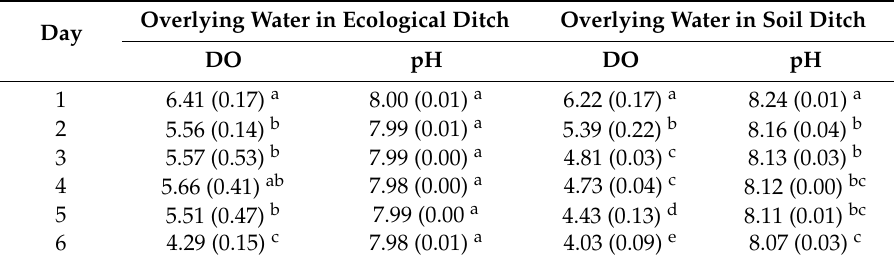
Figure 8. Changes of pH and dissolved oxygen (DO) in the eco-ditch and the soil ditch over time. Table 3. Effect of days on DO and pH of overlying water in the two ditches. Table 3. E ff ect of days on DO and pH of overlying water in the two ditches.